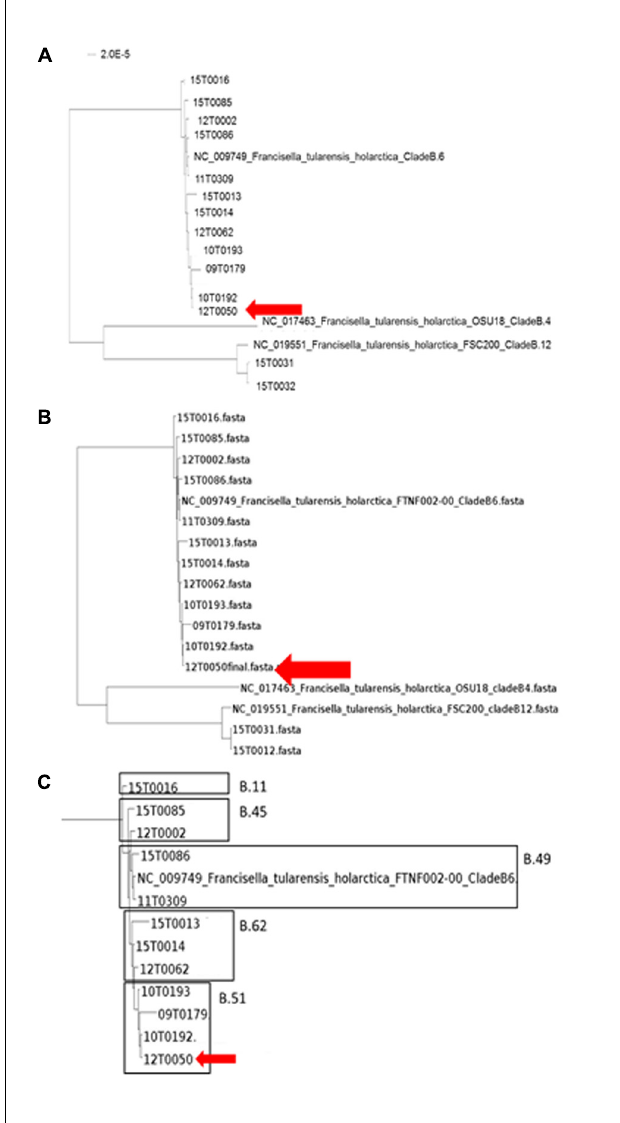
FIGURE 5 | Neighbor-Joining Phylogenetic Tree of the ParSNP core genome SNP analysis (A) . The trees were statistically evaluated with RaXML with a bootstrap analysis with 500 bootstraps. ( B and detailed view C , compared to canSNPer